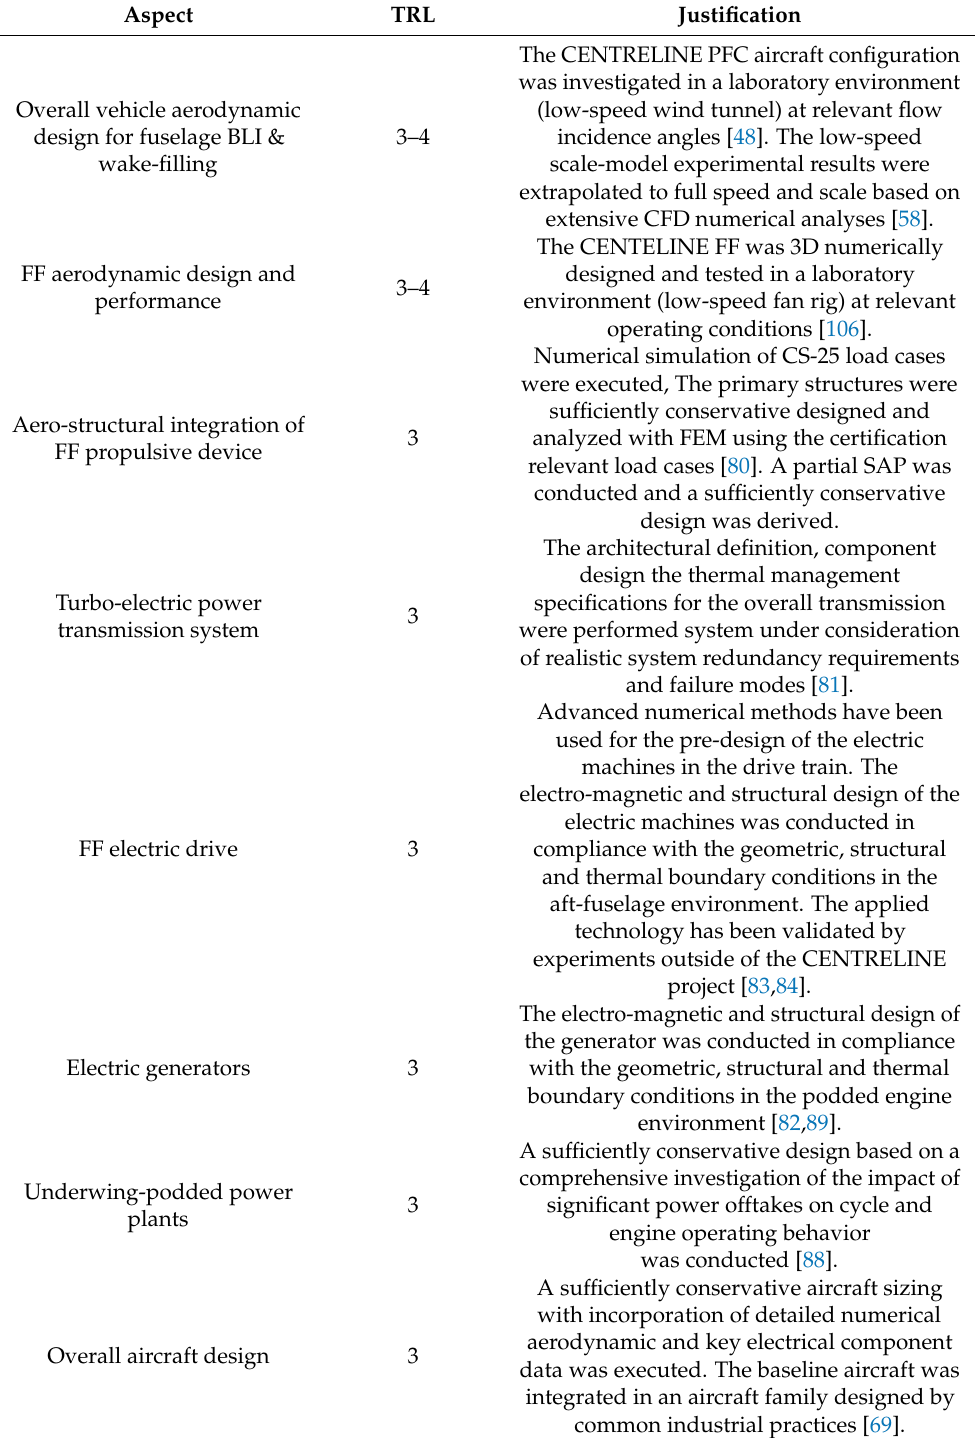
Table 14. Assessment of the current TRL of the PFC critical